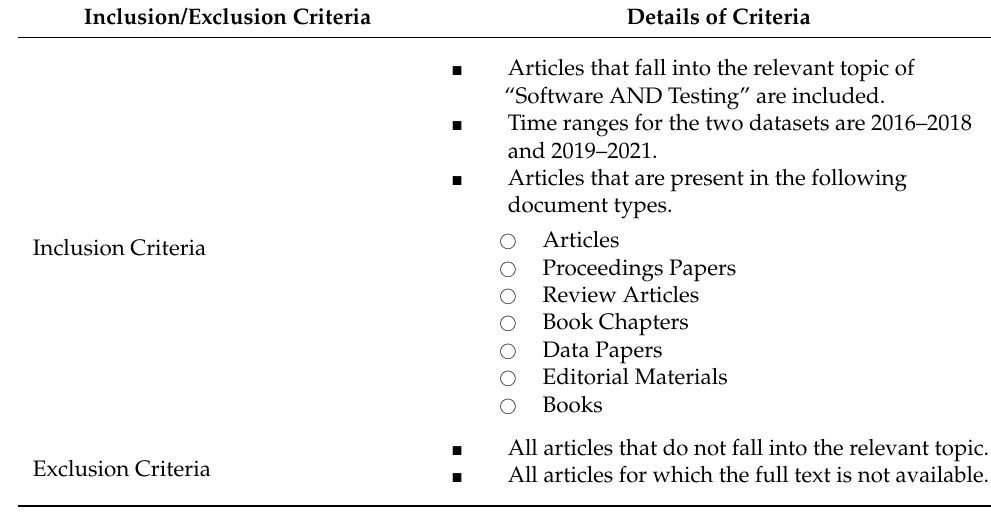
Table 3. The inclusion/exclusion criteria for the creation of datasets.